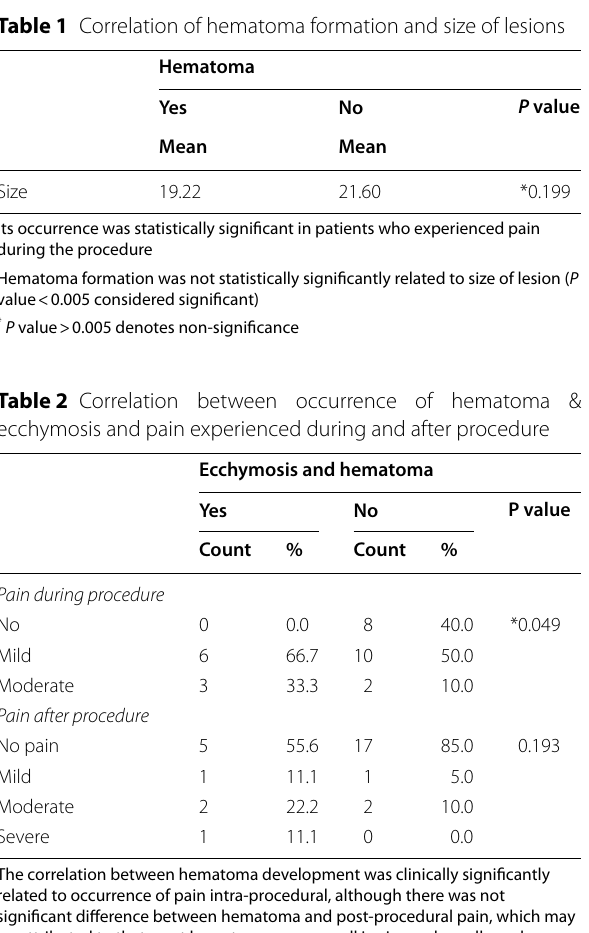
Table 1 Correlation of hematoma formation and size of lesions